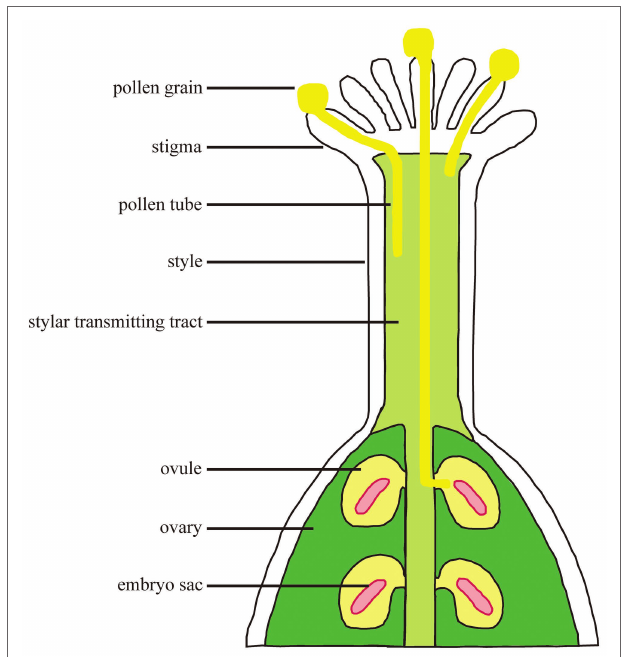
FIGURE 1 | The processes from pollination to fertilization. Pollen grains interact with stigma and germinate. Pollen tube polar growth along the transmitting tract. The pollen tube enters the female gametophyte for